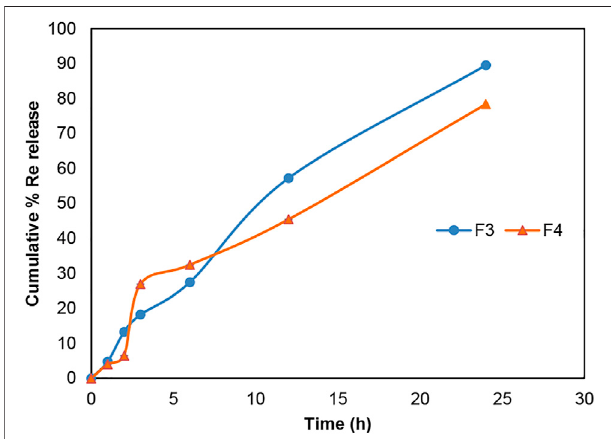
FIGURE 7 | Cumulative drug release pro fi le of Re(I) bisquinolinyl in Re + LCNPs, F3 and Gem:Re + LCNPs, F4 in various ratios over 24 h period. The graphrepresentsthepercentageofRe(I)complexconcentrationreleasedover 24 h (n = 3).